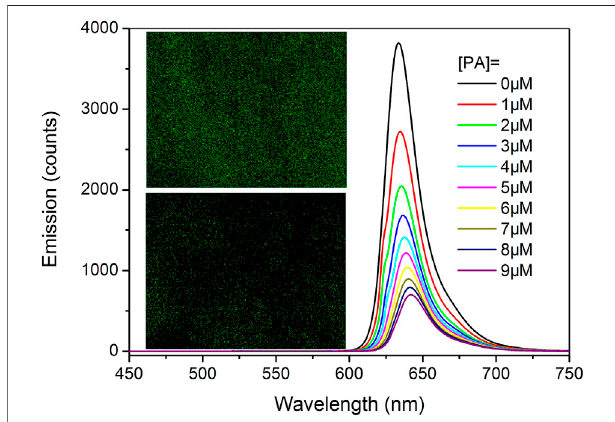
FIGURE 8 | I-COF emission intensity against increasing (PA). Inset: photos of Tb-COF before and after being treated with PA (10 μ